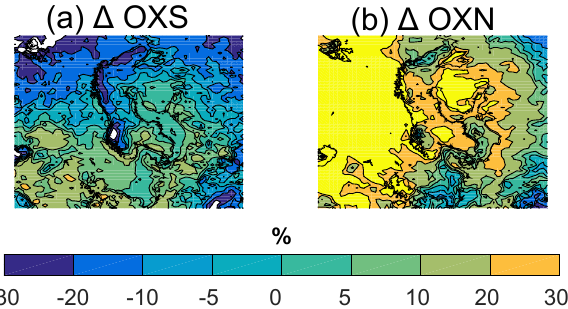
Figure 1. Difference (%) in deposition due to shipping, from EMEP model rv.4.4 to rv.4.8 run for the year 2011 for (a) oxidized sulfur and (b) oxidized nitrogen.